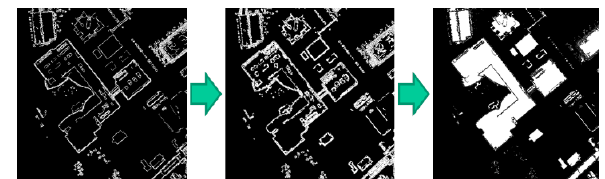
Figure 3. Example of building extraction